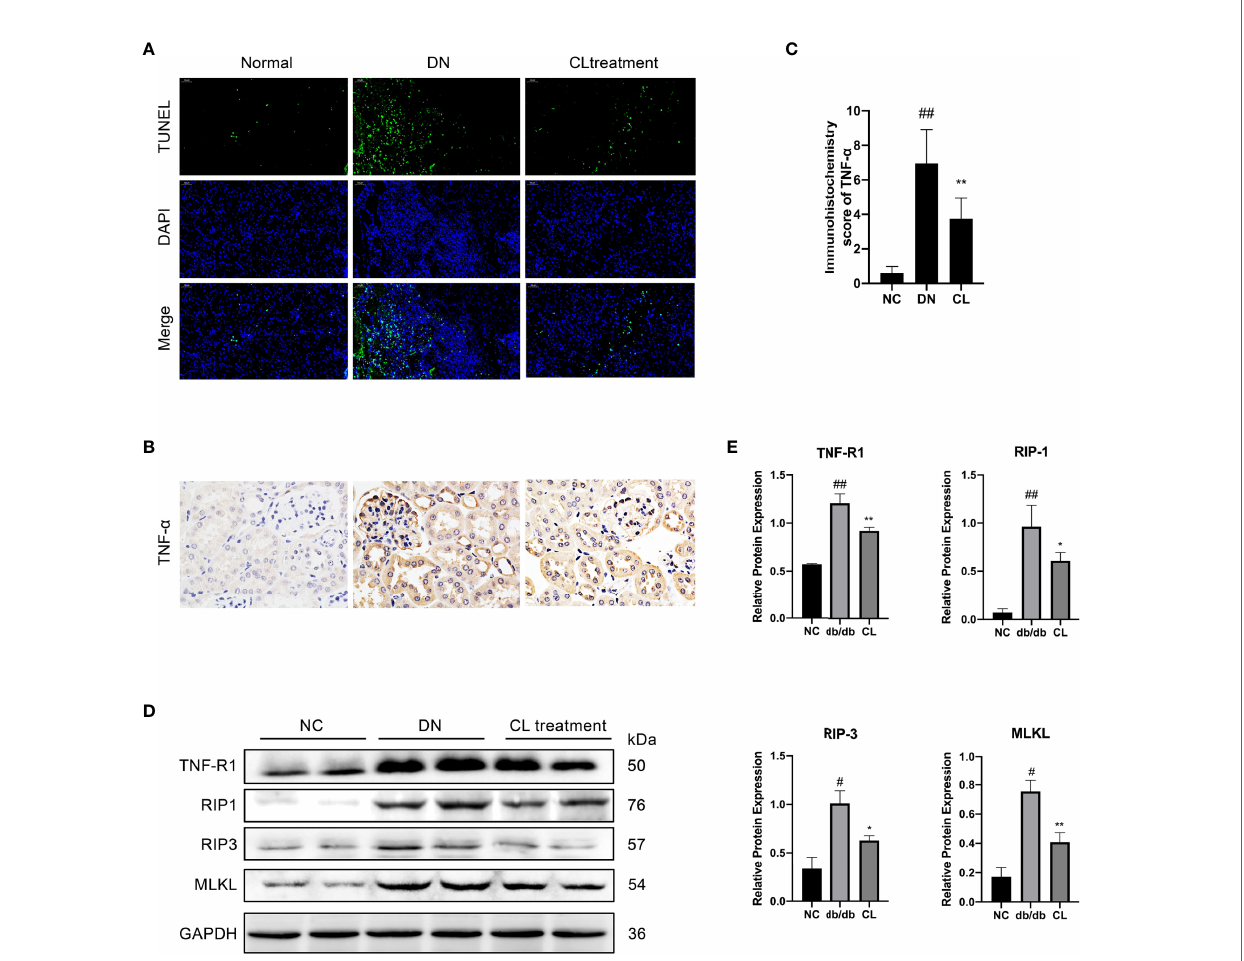
FIGURE 5 | Macrophage depletion reduces the necroptosis of renal tubular cells in diabetic mice. (A) TUNEL assay to detect cell death in renal tubulointerstitium of mouse, with counterstaining of cell nuclei (DAPI, blue). Original image magni fi cation: 200×. (B) Immunohistochemical staining shows the levels of TNF- a in kidney tissue. Original image magni fi cation: 200×. (C) Immunohistochemistry score of TNF- a . (D, E) Necroptosis pathway proteins RIP-1, RIP-3, and MLKL in the tissue were detected using western blotting, and GAPDH was used as the loading control. NC: normal control group (db/m), DN: diabetic nephropathy group (db/db), CL treatment: db/db + clodronate liposome treatment. # p < 0.05 vs. the normal group (db/m), ## p < 0.05 vs. the normal group (db/m), *p < 0.05 vs. the DN group (db/ db), **p < 0.01 vs. the DN group